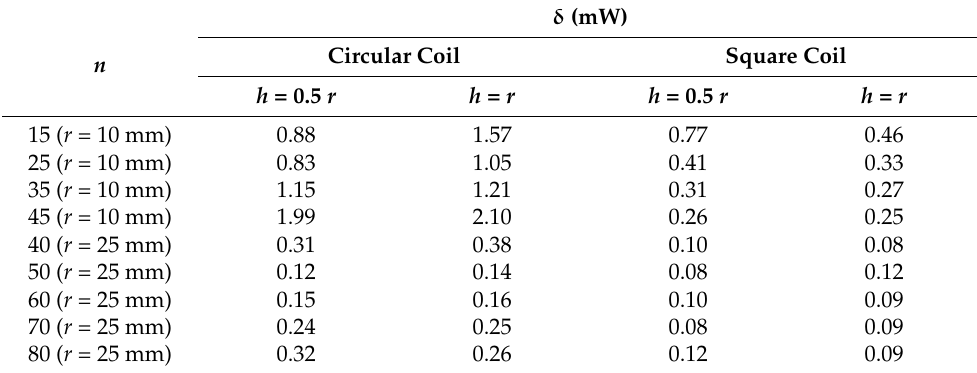
Table 11. Values of absolute error calculated for transferred power.